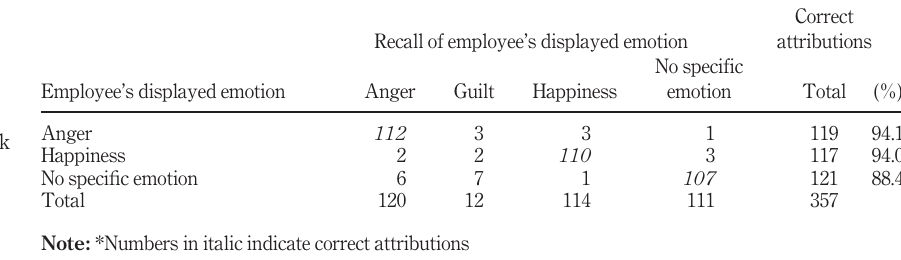
for the employee ’ s displayed emotion during service